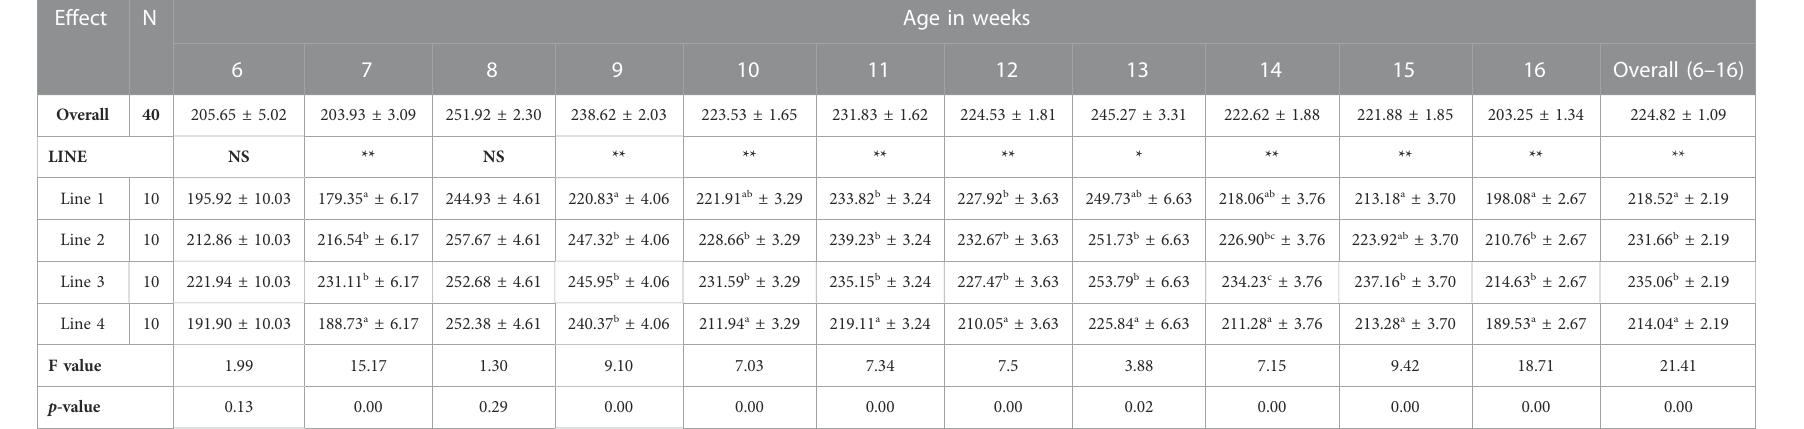
TABLE 8 Means (±S.E.) of feed consumption (g)/bird/week of different lines of Japanese quail from 6th to 16th week of age.